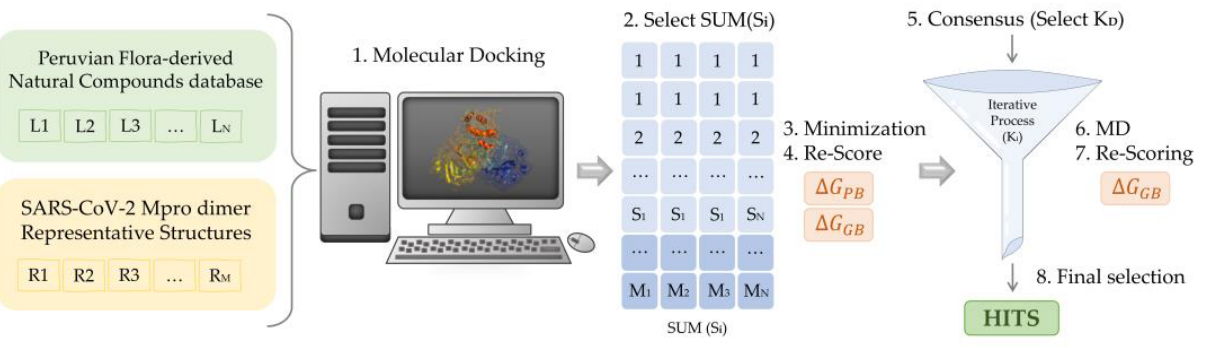
Figure 7. Scheme of the multistep virtual screening procedure carried out in the present work.